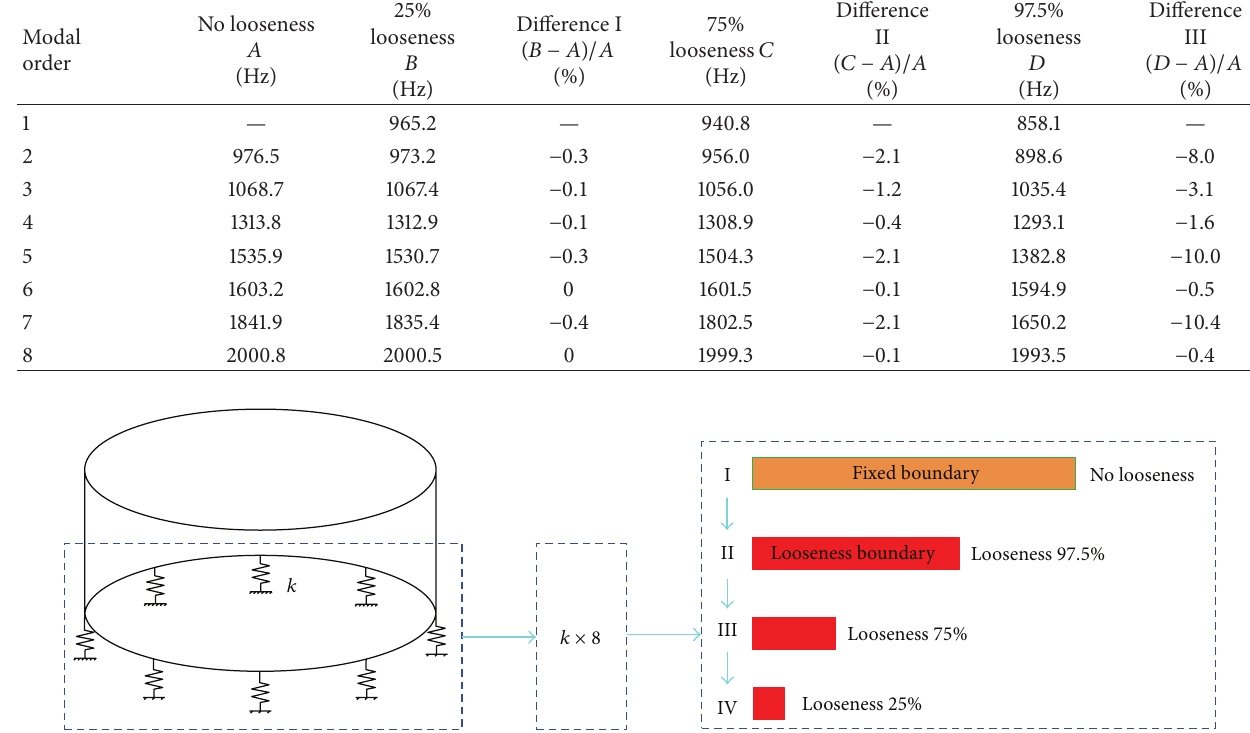
Table 4: Natural frequencies of TCS under BLB with different looseness levels.